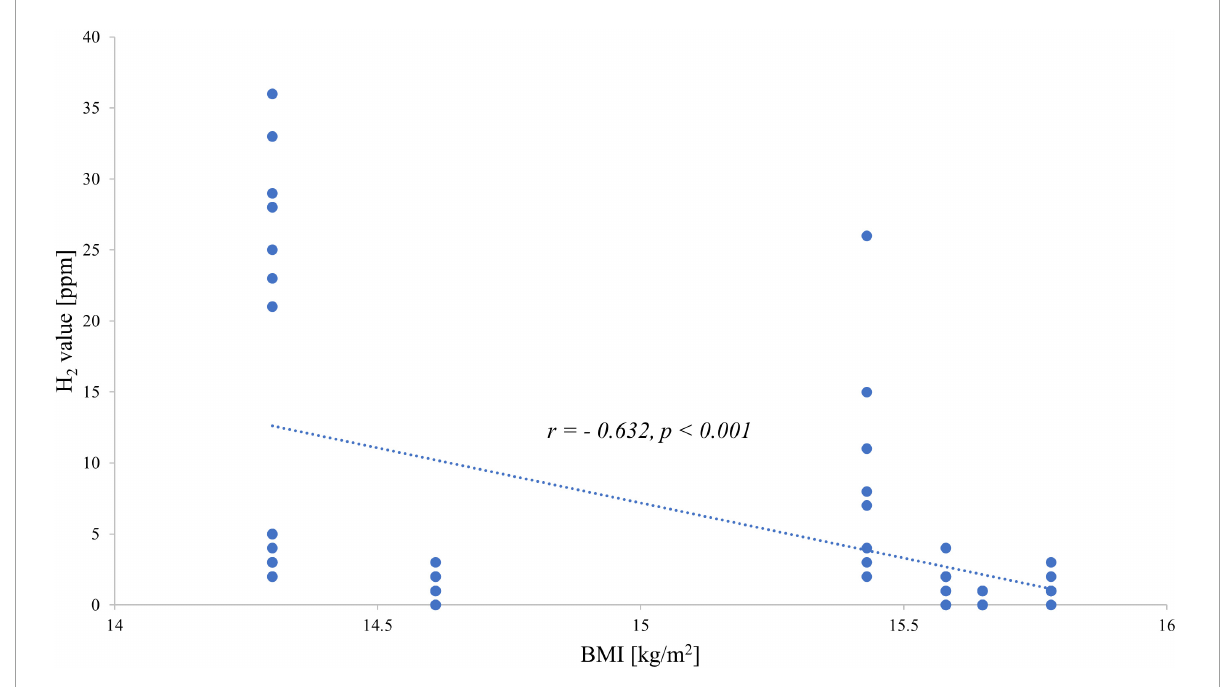
FIGURE1 Correlation between end-expiratory hydrogen values during the fructose breath test and body mass index.